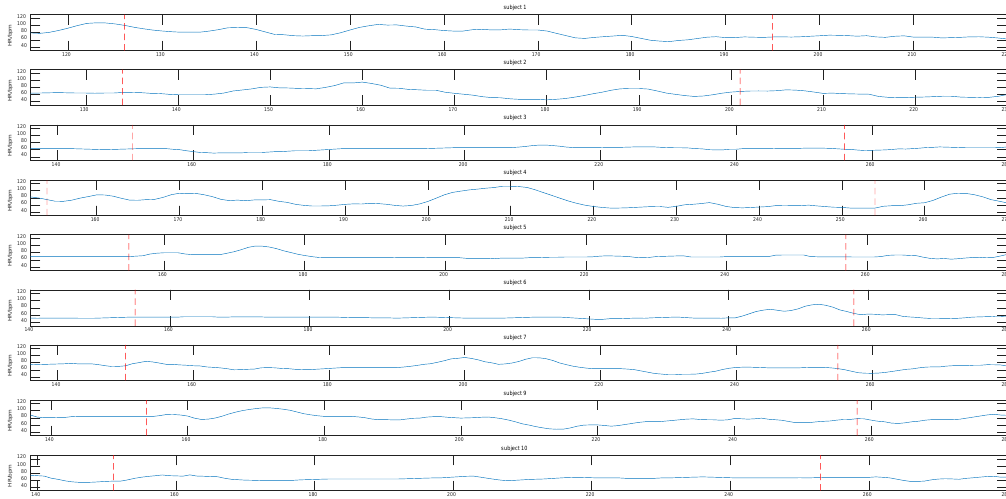
Figure 10. Heart rate changes when subjects imitated the expressions.